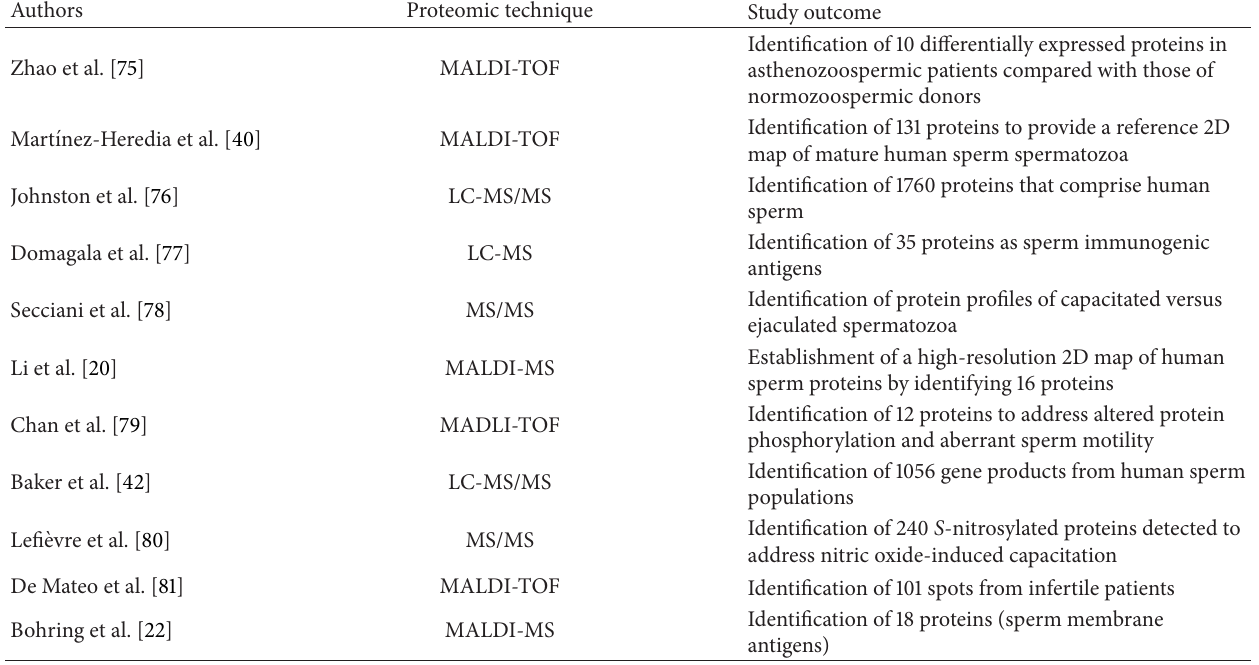
Table 2: Proteomic studies on human spermatozoa to access male